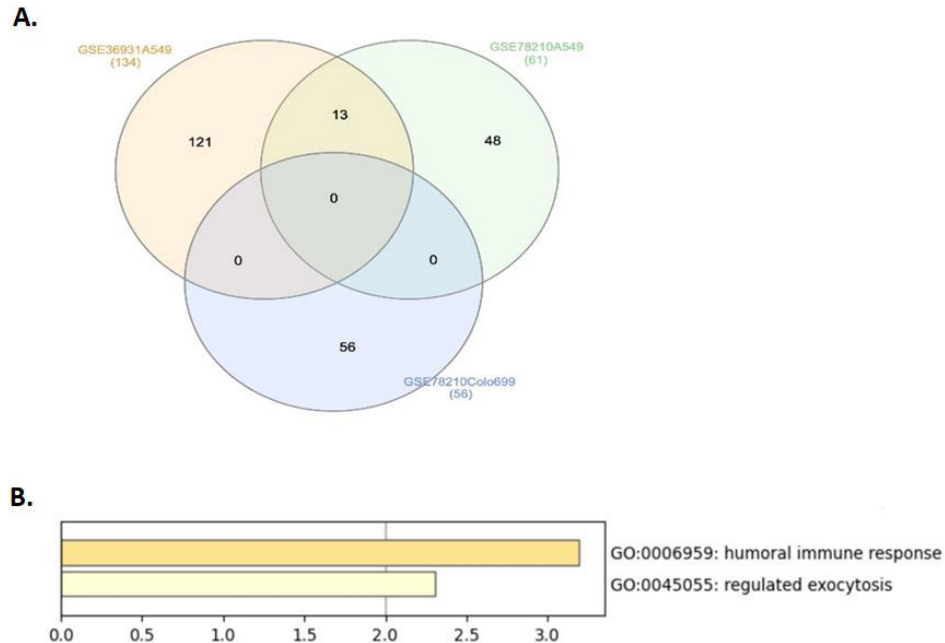
Figure 2. Thirteen commonly shared DEGs between GSE78210 and GSE36931 datasets in lung cancer. ( A ) Venn diagram showing 134 DEGs in GSE36931 (A549 cell line), 61 DEGs in GSE78210 (A549 cell line), and 56 DEGs in GSE78210 (Colo699 cell line) under SMG conditions as compared with GG. Out of the total identified 251 genes, 13 DEGs were found to be common between the two datasets, GSE78210 and GSE36931, in A549 cell line. Venn diagram was generated using InteractiVienn. Gene enrichment analysis was applied to the identified 13 genes. ( B ) Using Metascape (http://metascape.org; accessed on 11 November 2021), these genes are enriched in pathways related to humoral response and regulated exocytosis, using gene enrichment